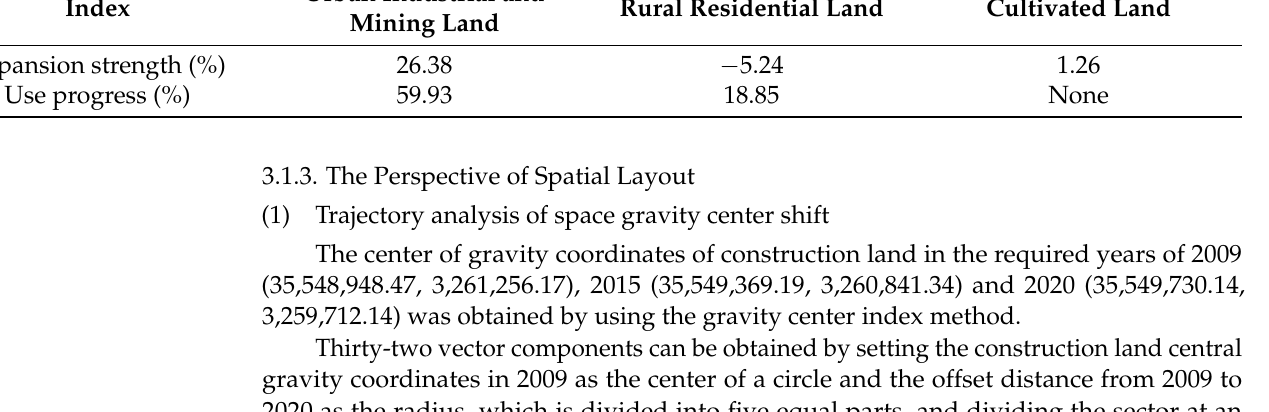
Table 5. Various types of land expansion and indicator utilization progress during the evaluation period in Rongchang District. Index